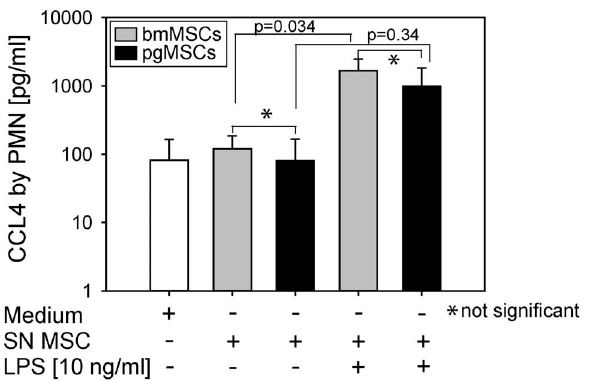
Figure 6. CCL4 secretion by PMNs. PMNs were cultured in control medium or in conditioned medium of unstimulated or LPS-stimulated MSCs for 24 hours. CCL4 secreted by PMNs was measured by ELISA. Data are presented as median of 3 independent experiments. ANOVA test was used for statistical analysis; significance was set at the level of P #